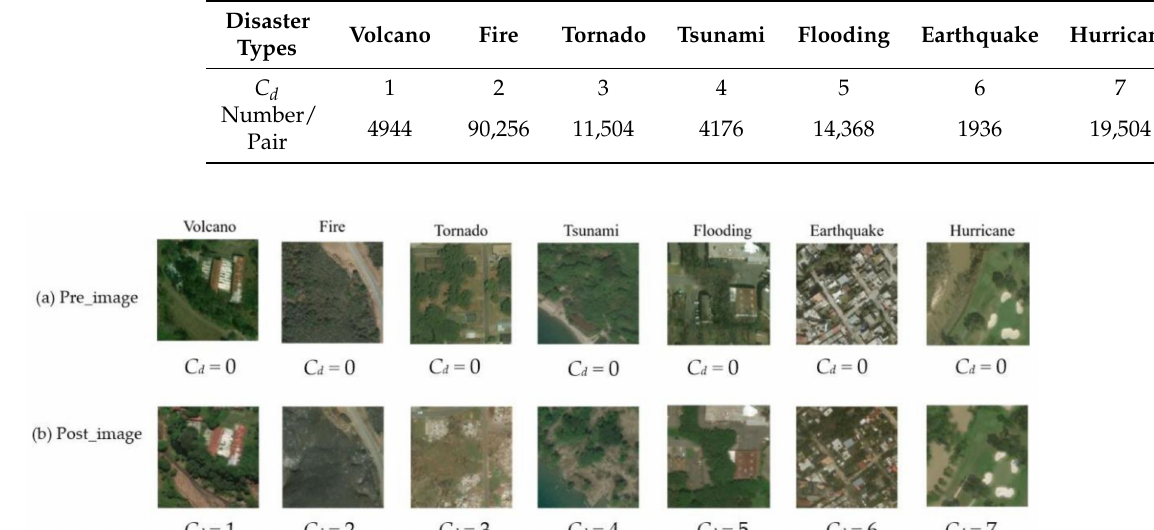
Table 5. The statistics of disaster data set.